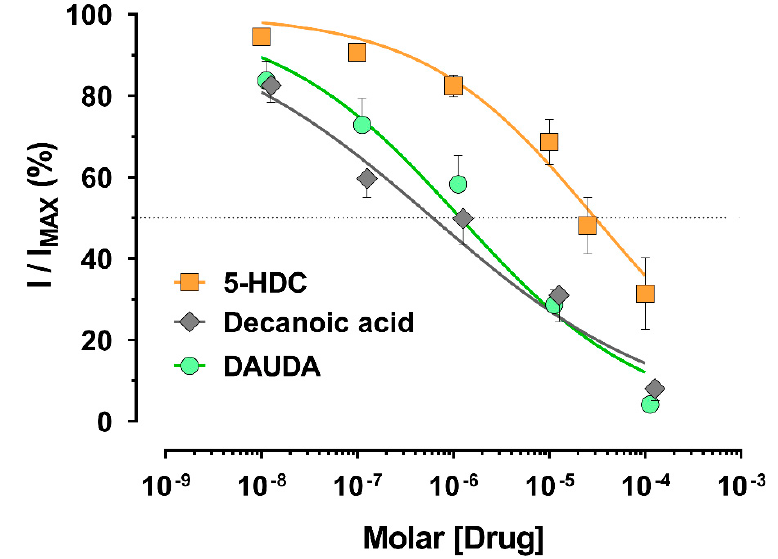
Figure 2. Concentration-response curves of compounds on AgKv2.1 channels. Patch-clamp whole-cell recordings were performed on HEK-293 cells expressing AgKv2.1 channels. Current inhibition was determined at +60 mV. Current amplitude for each concentration of compounds was related to a control recording with extracellular solution without drug. Compounds were diluted in 0.1% DMSO final. The concentration that inhibited 50% of the control current amplitude (IC 50 ) was determined and reported in Table 1. The dotted line is the 50% inhibition level.